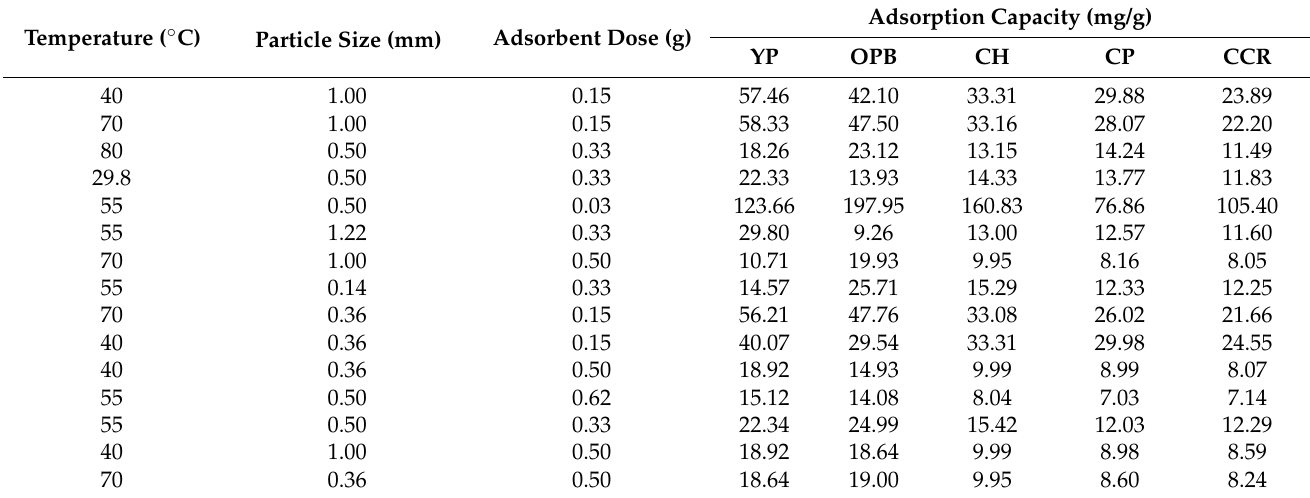
Table 2. Cd 2+ adsorption capacity by varying temperature, particle size and adsorbent dose.